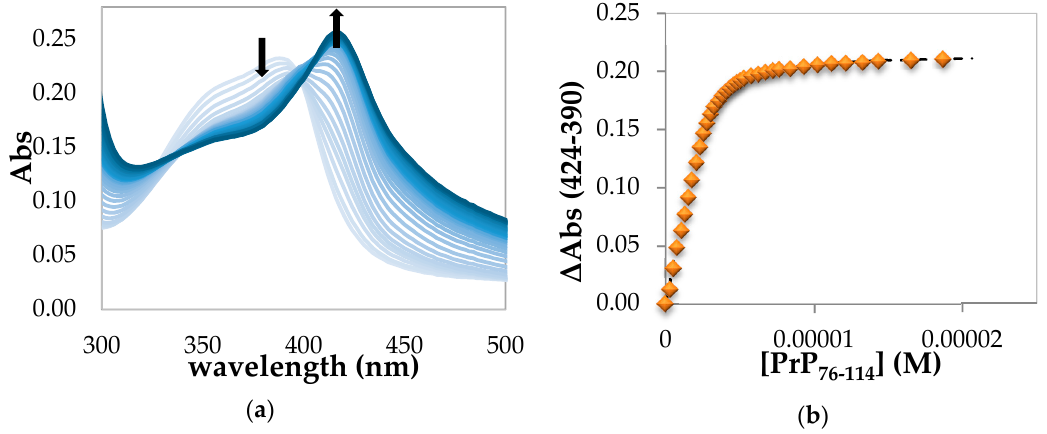
Figure 6. ( a ) UV–Vis spectrophotometric titrations in 20 mM phosphate buffer solution, pH 7.4, showing the decrease in intensity of the Soret band upon binding of hemin (2.74 μ M) with PrP 76–114 (from 0 to 7 equiv., light blue to blue) in a cell of 1 cm path length. The arrow pointing down at 390 nm indicates the hypochromic effect due to the formation of a high-spin hemin-PrP complex; the arrow pointing up at 416 nm indicates the formation of a low-spin complex; ( b ) absorbance changes with respect of free hemin at 424 nm with subtraction of the contribution at 390 nm vs. PrP 76–114 concentration fitted by high-affinity equation described in the Materials and Methods section.